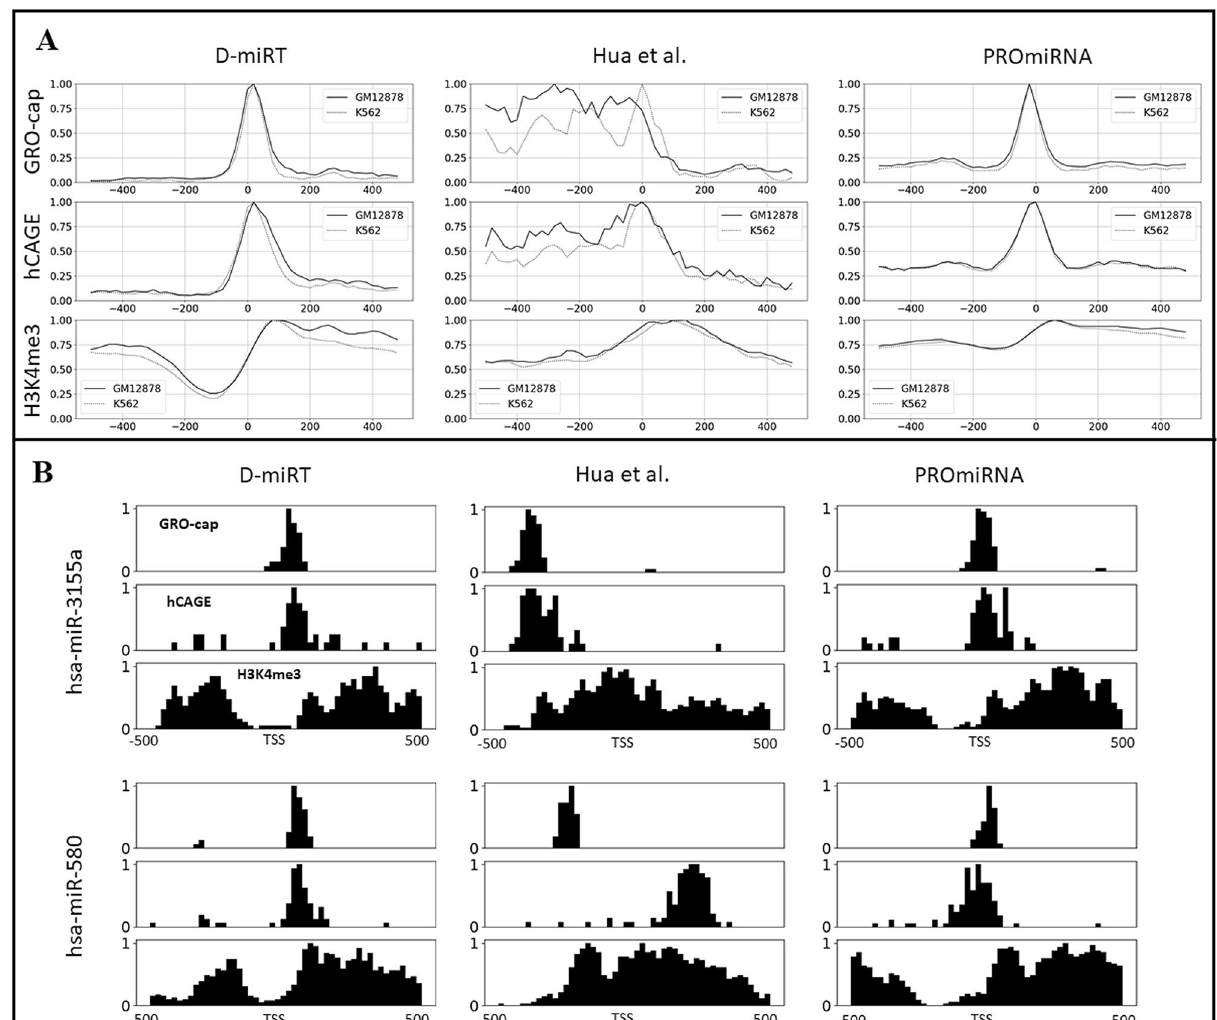
Figure 2. Experimental evidence for D-miRT predicted TSSs. (A) The average distribution of GRO-cap, CAGE tags and H3K4me3 in the ± 500 bp regions surrounding the predicted TSSs by D-miRT, Hua et al., 2016 and PROmiRNA in GM12878 and K562 cell lines. (B) The distributions of GRO-cap, CAGE tags and H3K4me3 in K562 cell line for two example miRNAs across the ± 500 bp regions surrounding the predicted TSSs by D-miRT, Hua et al., 2016 and